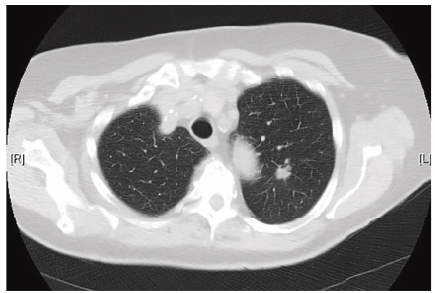
Figure3:CTofthechestparenchymalviewdemonstratingleftlobar consolidation with ground glass attenuation and proximal bronchial tapering (white asterisk).